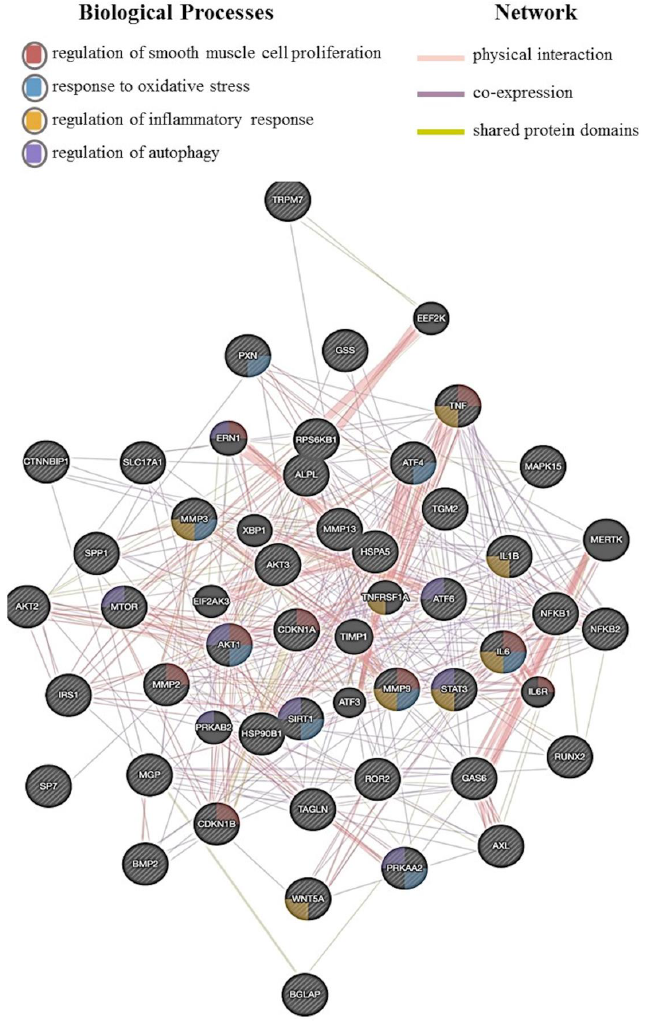
Figure 3. A network analysis of gene involved in VSMCs calcification. The network shows the correlations between genes. Each node represents a gene, and the relationship between two different genes is described with a line (physical interaction, co-expression, and shared protein domains). The analysis highlighted 4 biological processes relevant to VSMC calcification: regulation of smooth muscle cell proliferation, response to oxidative stress, regulation of inflammatory response, and autophagy.